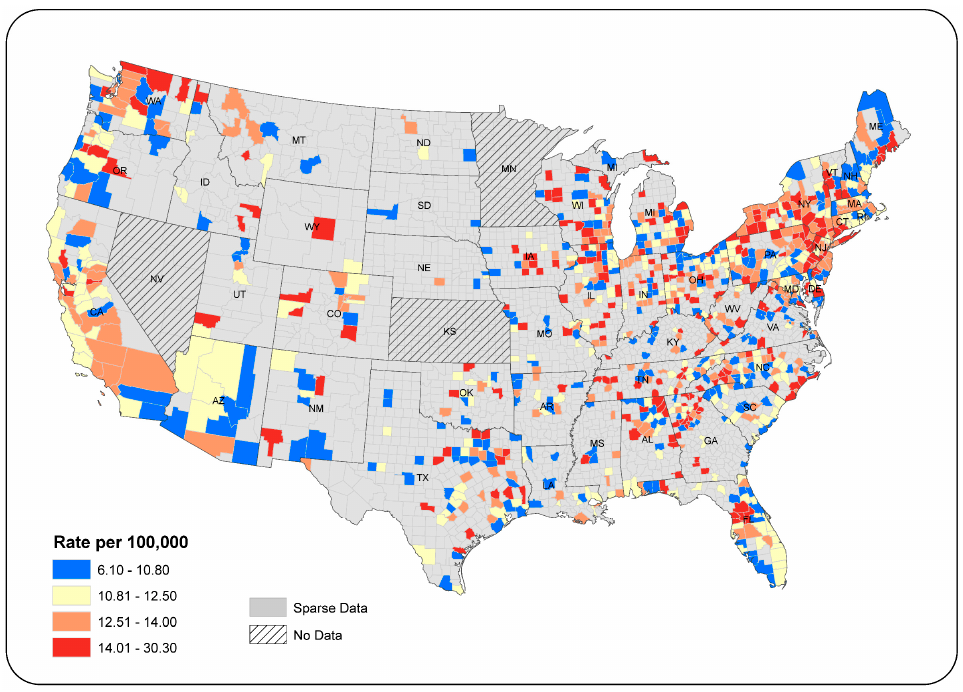
Figure 1. County ‐ level ovarian cancer incidence per 100,000 population, 2009–2013, whites. Figure 1. County-level ovarian cancer incidence per 100,000 population, 2009–2013,